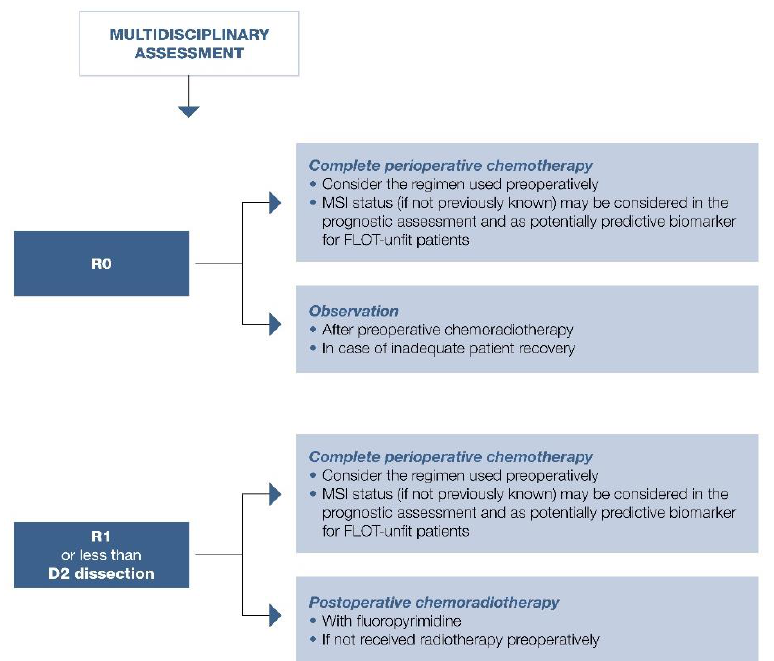
Figure 2. Treatment options for fit patients with resectable gastric or gastroesophageal junction adenocarcinoma already treated with preoperative therapy and surgery. FLOT, 5-fluorouracil/leucovorin, oxaliplatin, and docetaxel; MSI, microsatellite instability.